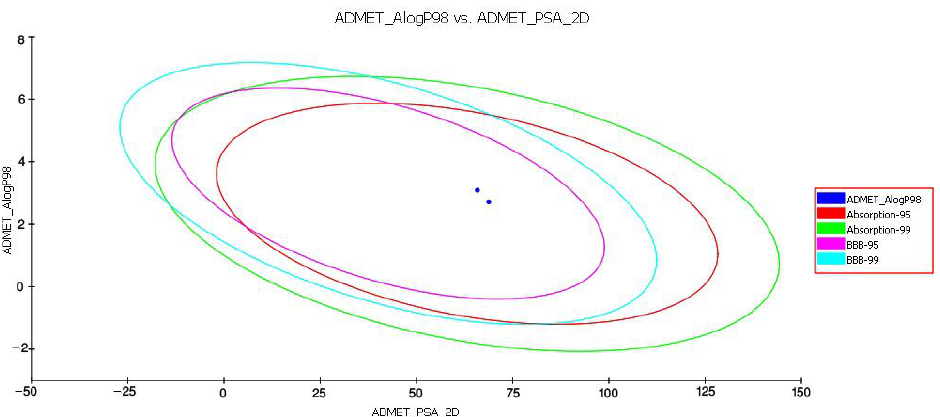
Figure 9. Plot of polar surface area ( PSA ) vs. LogP for D5 and D4 . Data show the 95% and 99% confidence limit ellipses corresponding to the blood–brain barrier and intestinal absorption models.